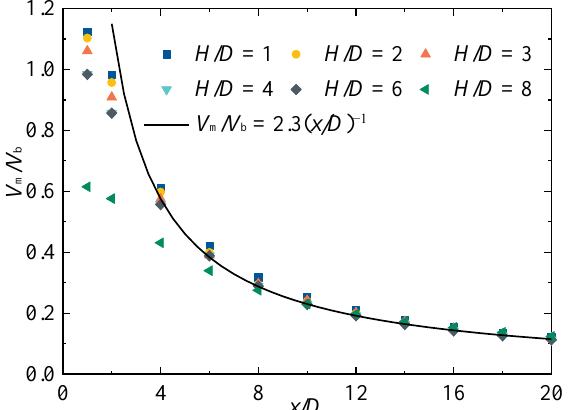
Figure 15. Variation of normalized maximum velocity V m /V b of the wall jet along the forward flow direction.